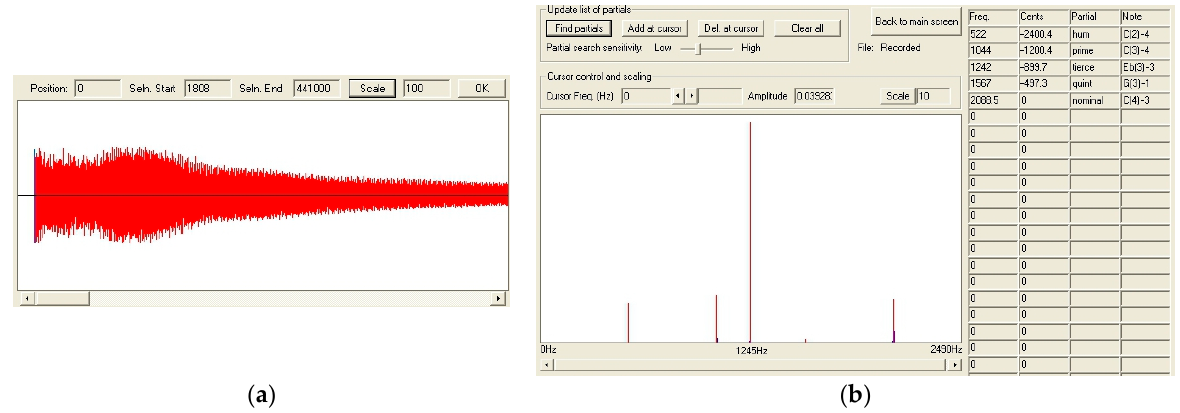
Figure 9. The spectrum of the St. Maryan bell’s sound, before (BW) and after (AW) welding.